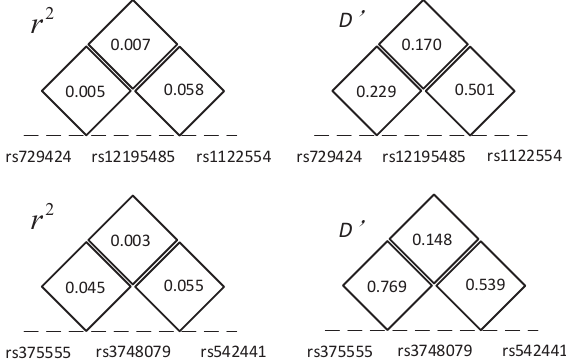
Figure 6. The linkage disequilibrium (LD) between SNPs in the two three-locus combination detected in CD